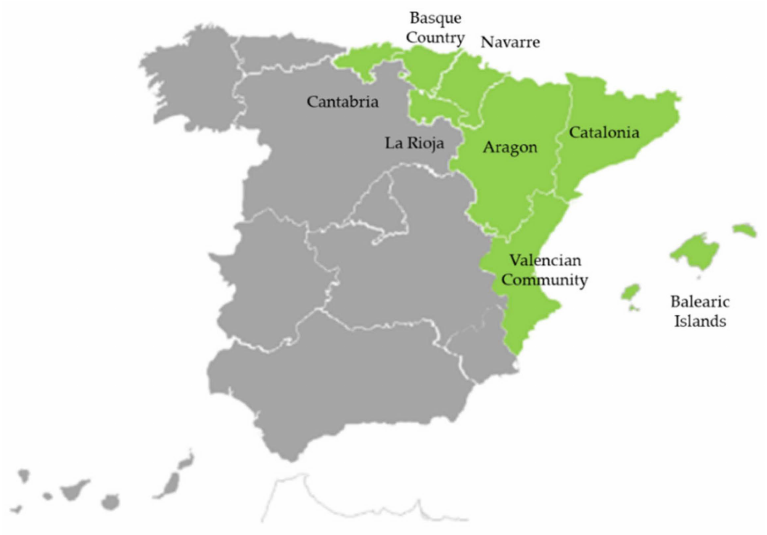
Figure 1. Cantabrian-Mediterranean Bioregion in the Spanish map (in green).